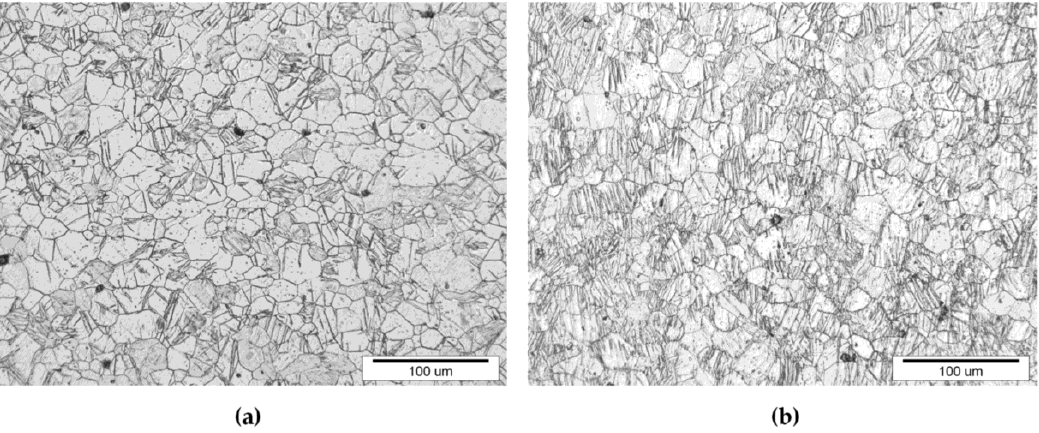
Figure 2. Microstructure of the specimens: ( a ) after tensile loading; ( b ) after cyclic loading.